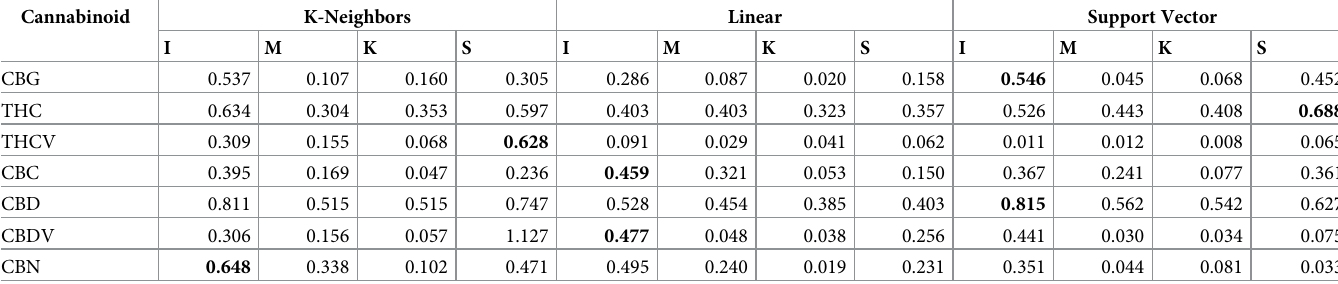
The three machine learning models -K-neighbors, linear, and support vector- predict the cannabinoid concentration using data from four different imputation methods: iterative, multiple, k-neighbors, and soft. The best-performing models are bolded. (The R 2 value for CBDV under K-Neighbors regression using soft imputation values exceeds 1 because of the mean squared